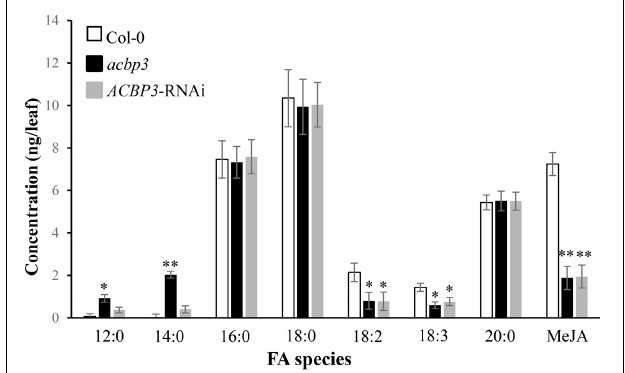
FIGURE 5 | Quantitative gas chromatography-mass spectrometry analysis of fatty acids from phloem exudates of 5-week-old wild-type Col-0 Arabidopsis, acbp3 and AtACBP3- RNAi lines. Error bars represent standard deviation ( n = 3) in each analysis. The Student’s t- test was used for statistical analyses. “ ∗ ” indicates a statistically significant ( P < 0.05) elevation or reduction in comparison with the wild-type Col-0. “ ∗∗ ” indicates a very statistically significant different ( P < 0.01) elevation or reduction in comparison with the wild-type Col-0. These experiments were repeated twice with consistent